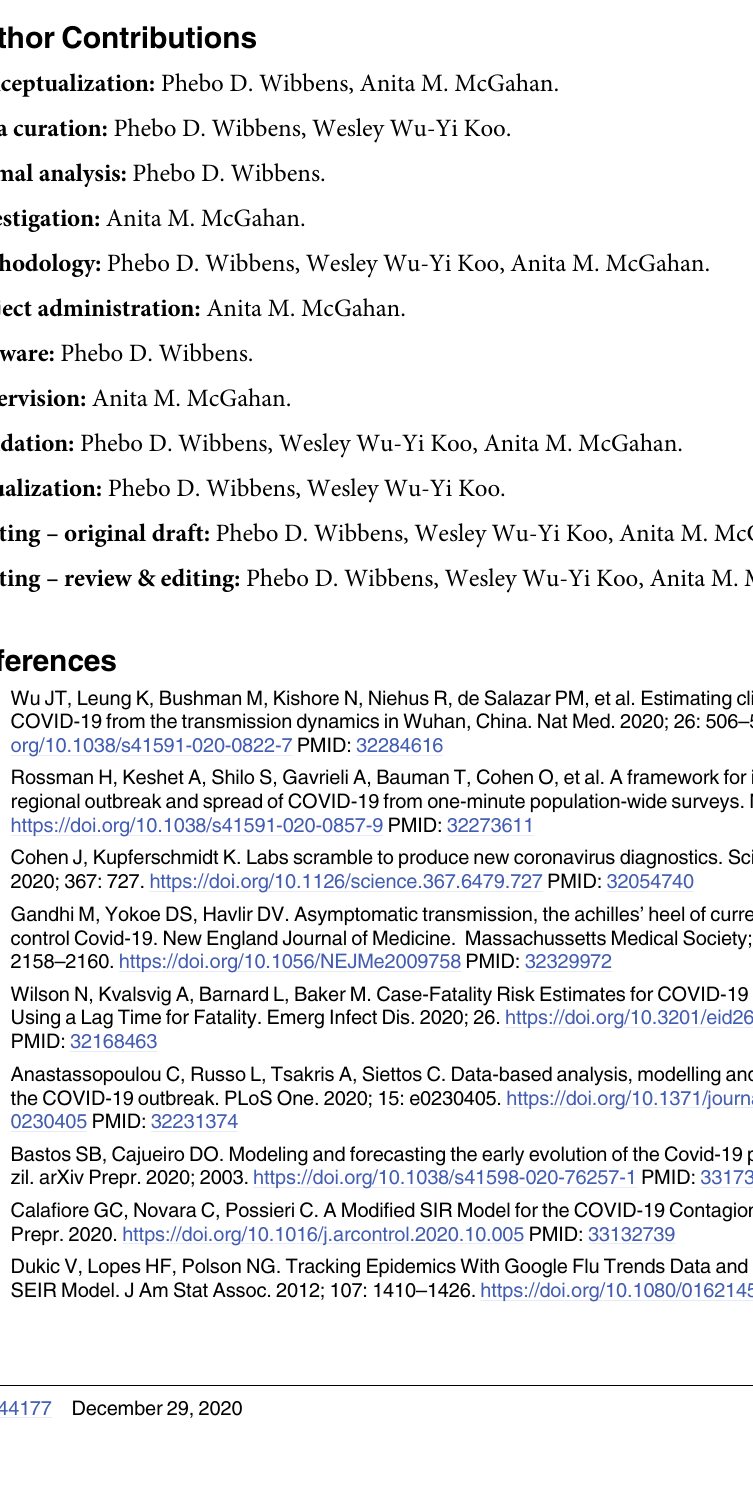
S1 Table. Posterior median and 95%-interval estimates for key variables of interest, as well as Bayesian estimate statistics n S2 Table. Variance inflation factors for the policy fixed effects δ